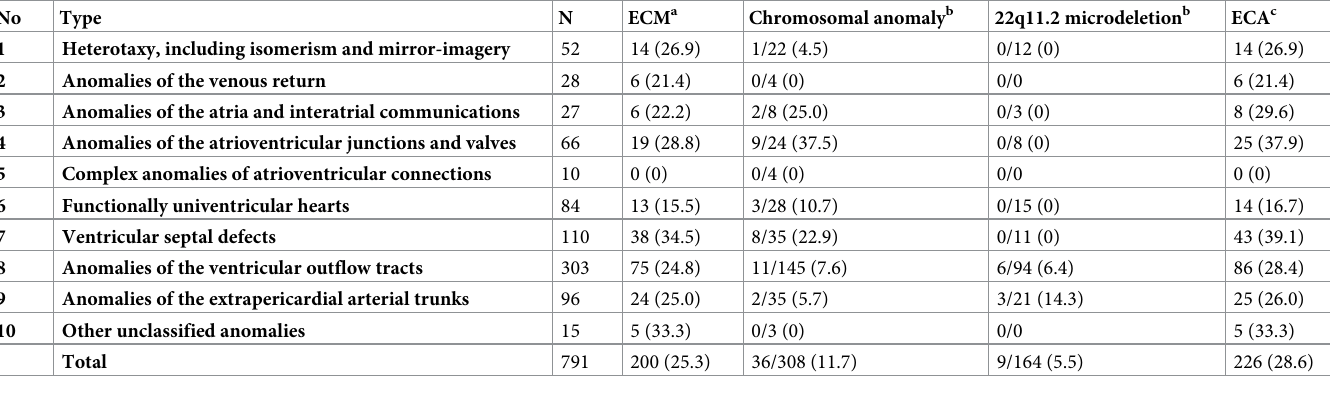
univentricular hearts (n = 84). The prevalence of ECA in the total CHD population was 28.6% (226/791). The prevalence of ECA was the highest in those with VSD (39.1%), followed by that of anomalies of atrioventricular junctions and valves (37.9%), unclassified anomaly (33.3%), and anomalies of atria and interatrial communications (29.6%). Prevalence of ECM, chromo- somal anomaly, and 22q11.2 microdeletion were 25.3% (200/791), 11.7% (36/308), and 5.5% (9/164), respectively.